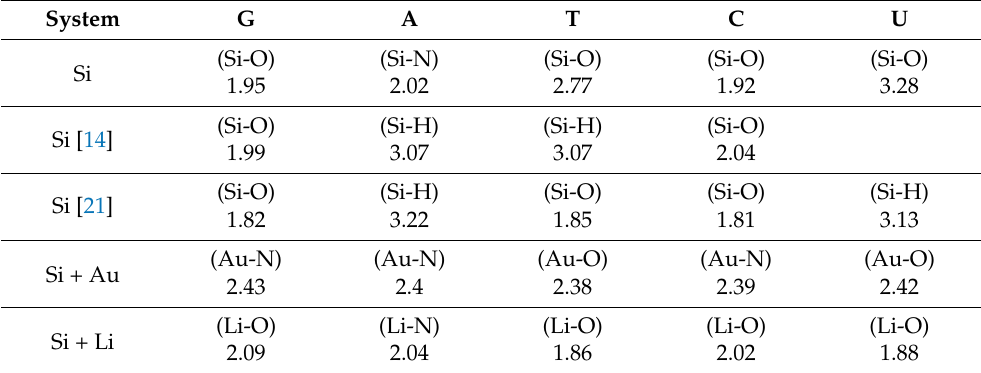
Table 2. The closest adsorption of distances between the monolayer atom (Si)/adatom (Li/Au) and the closest atom of the nucleobases. Values are in A 0 .